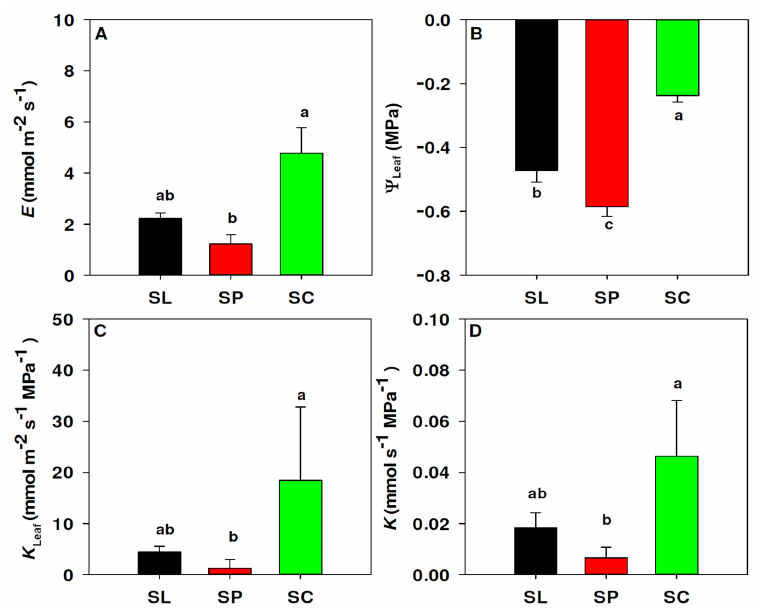
Figure 2. Differences in leaf hydraulics between S. lycopersicum (black, SL), S. peruvianum (red, SP) and S. chilense (green, SC). Water flux E ( A ), water potential Ψ Leaf ( B ), area-adjusted leaf hydraulic conductance K Leaf ( C ) and total leaf hydraulic conductance K ( D ). Values in ( A , C , D ) represent the median and 75% percentile. Values in ( B ) represent the mean and standard error. Different letters represent significant differences ( p < 0.05) according to Fisher ( B ) and Dunn’s ( A , C , D ) tests.